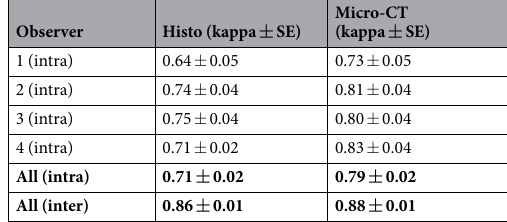
Table 4. Agreement (as expressed by intra- and inter-rater Kappa) for histology and